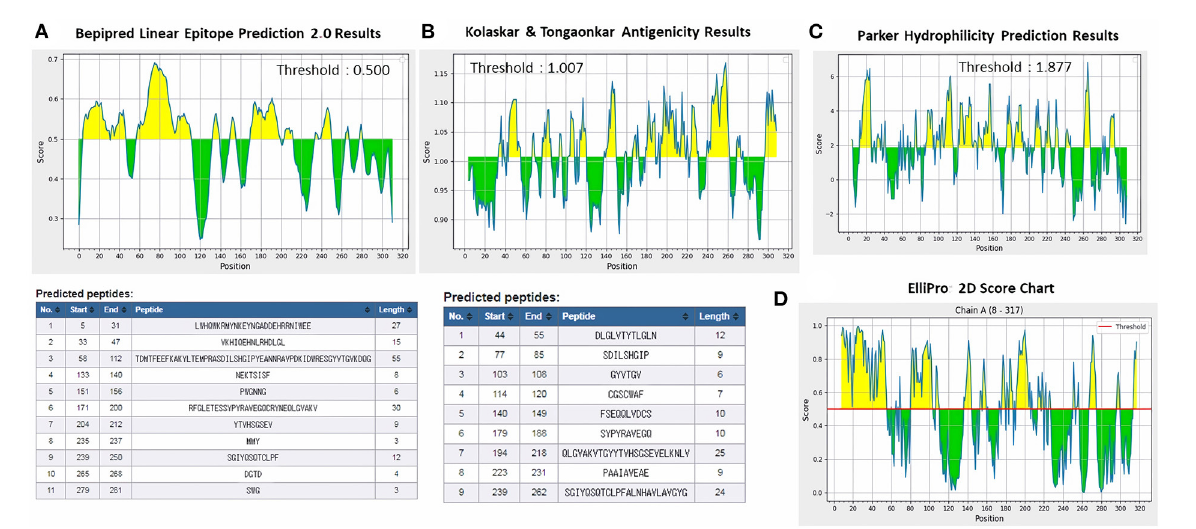
FIGURE7 Immunogenicity, antigenicity, and hydrophilicity of FhCatL1 protein. (A) Bepipred linear epitopes prediction; (B) Antigenicity; (C) Hydrophilicity; (D) ElliPro: 2D Score Chart epitope prediction. x -axis and y -axis represent position and score, respectively. The horizontal line indicates the threshold or the average score. Yellow colors (above the threshold) indicate favorable regions related to the properties of interest. Green color (below the threshold) indicates the unfavorable regions related to the properties of interest. The results were analyzed by the Immune Epitope Database (IEDB)